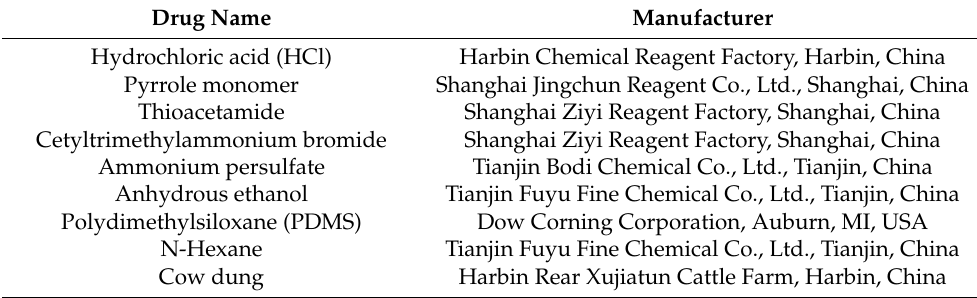
Table 1. Experimental reagents. Drug